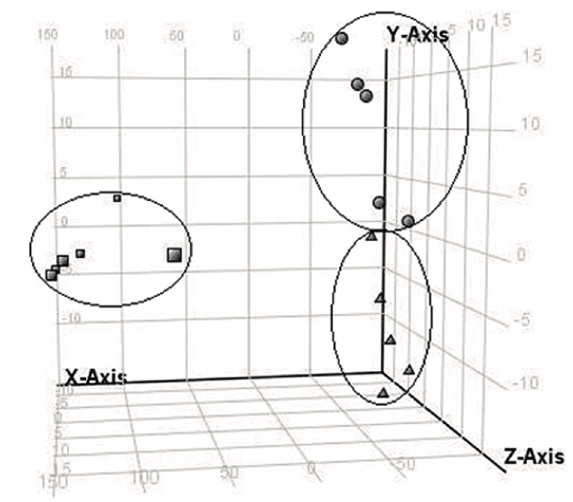
Figure 3. PCA score plot resulting from urine metabolic profiling of control ( ■ ), FA 4 mg/m 3 group ( ● ), and FA 8 mg/m 3 group ( ▲ ) on day